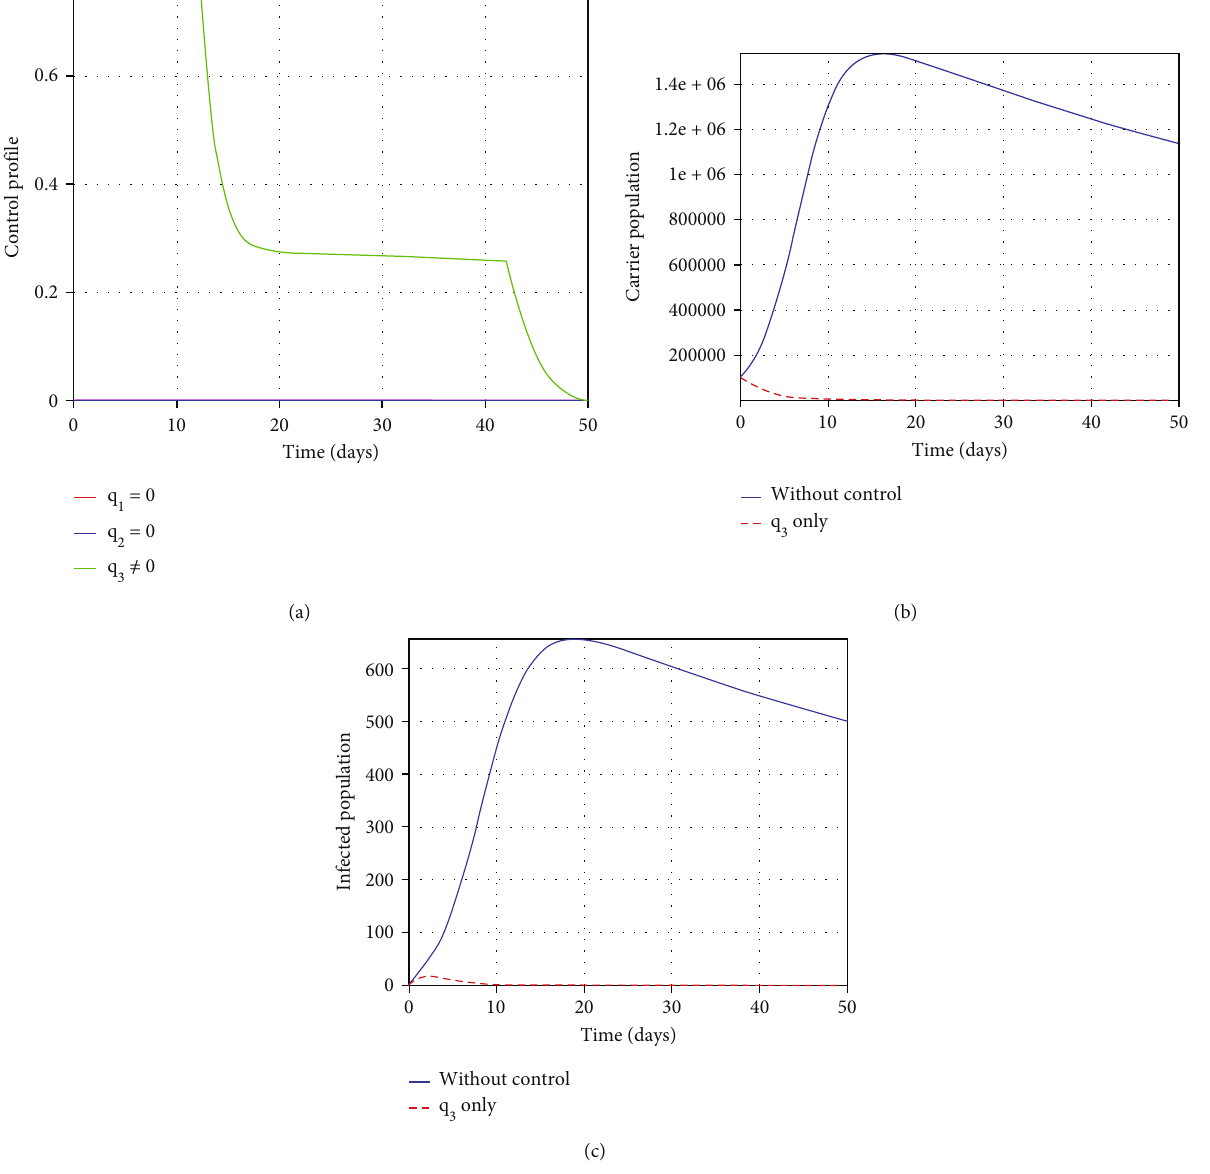
Figure 8: E ff ect of using personal protection only. The control graph in (a) clearly shows that 100% of the population is required to apply personal protection strategies and this should be done for 12 days to help eradicate the meningitis disease. The impact and e ff ectiveness of this control strategy in averting the exponential growth in meningitis are seen in the decrease of (b) carriers and (c) infected